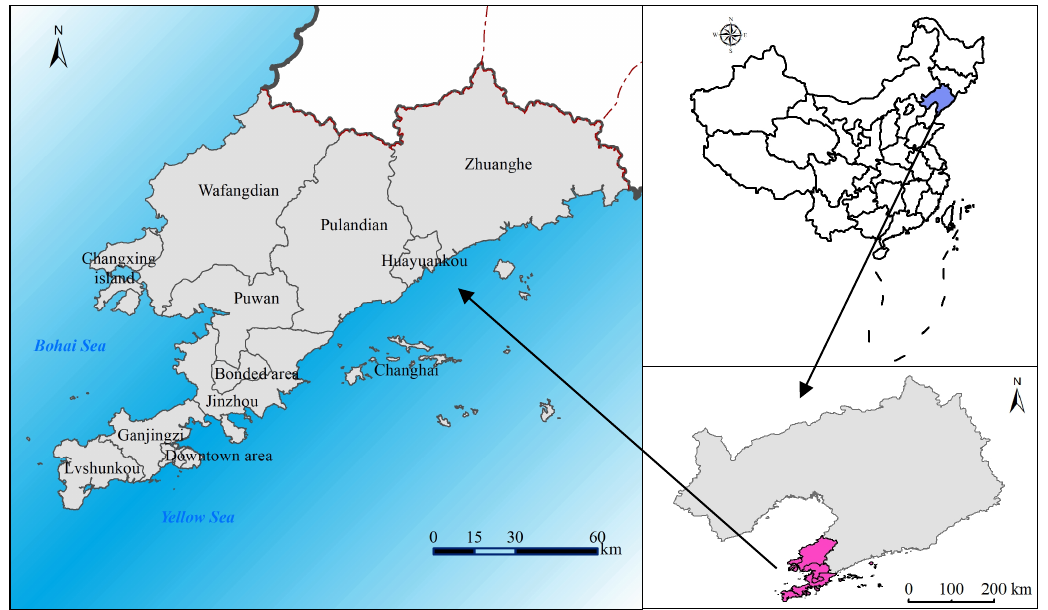
Figure 1. The location of the study area.